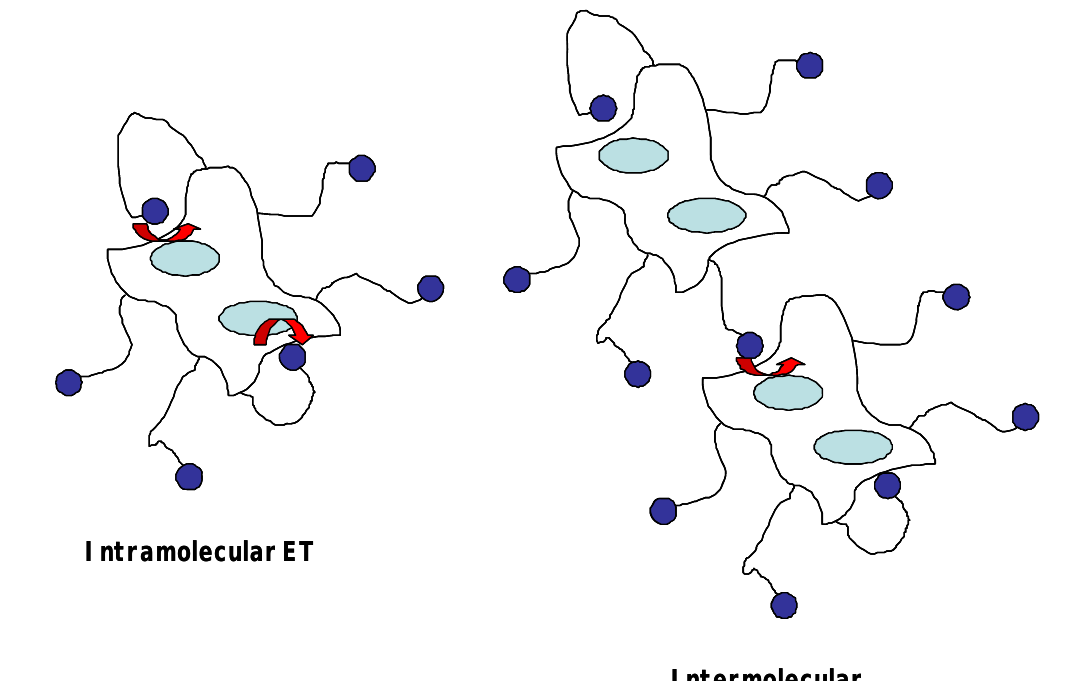
Figure 1. Schematic representation of ‘electro-enzymes’ indicating how tethered redox mediators can exchange electrons with the enzyme catalytic site buried within the protein sheath. This electron transfer may occur via unimolecular intramolecular or via bimolecular intermolecular mechanisms as